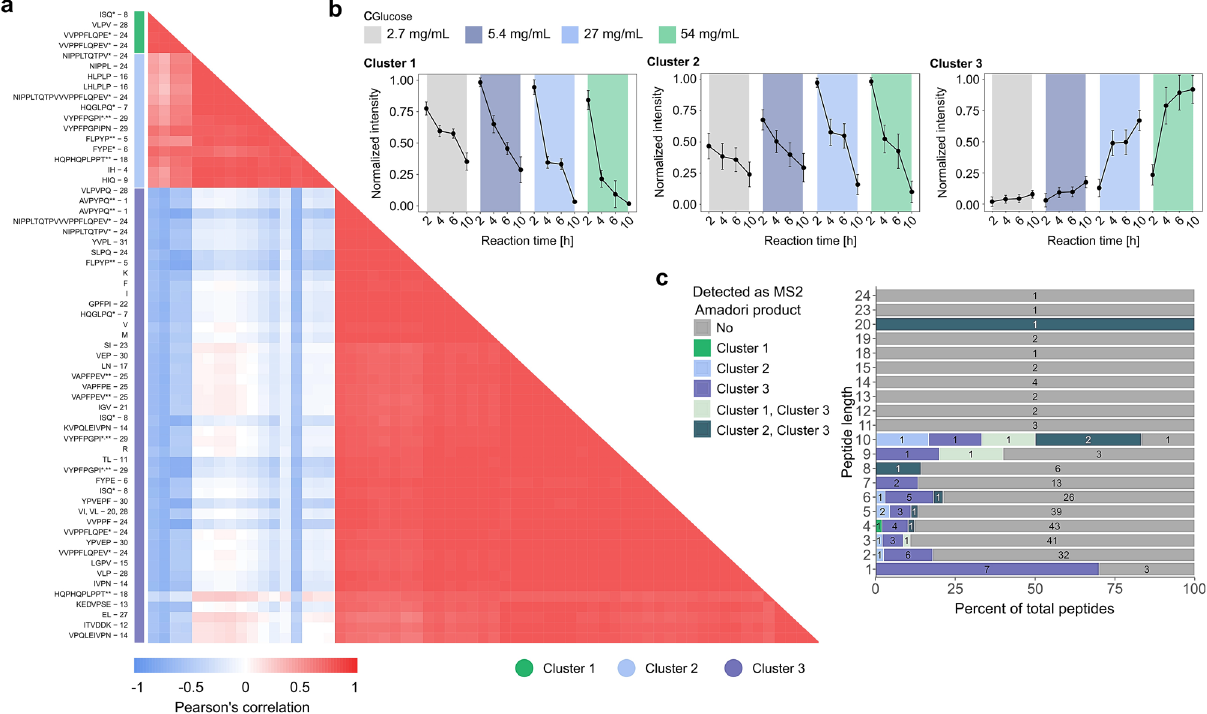
Figure 2. Intensity profiling enables classification of APs identified. (a) Pearson’s correlation heatmap computed for the intensity profiles from the APs confirmed by MS/MS fragmentation pattern. Rows are ordered by unsupervised hierarchical clustering. Positive values (red) represent higher similarity in formation/degradation rates. Negative correlation values are colored in blue. Asterisks denote APs from the same peptide (* isomers; ** different charge states). Suspended numbers indicate peptides with similar amino acid sequences. ( b) Intensity profiles visualize time-resolved AP formation depending on the glucose concentration. Intensity values were normalized towards the greatest intensity value. Colors indicate different glucose concentrations. ( c) A stacked bar plot shows the percentage of the total number of peptides of a certain length that were identified as an AP (colored bars). Different colors provide information on the assigned clusters as identified in (a)